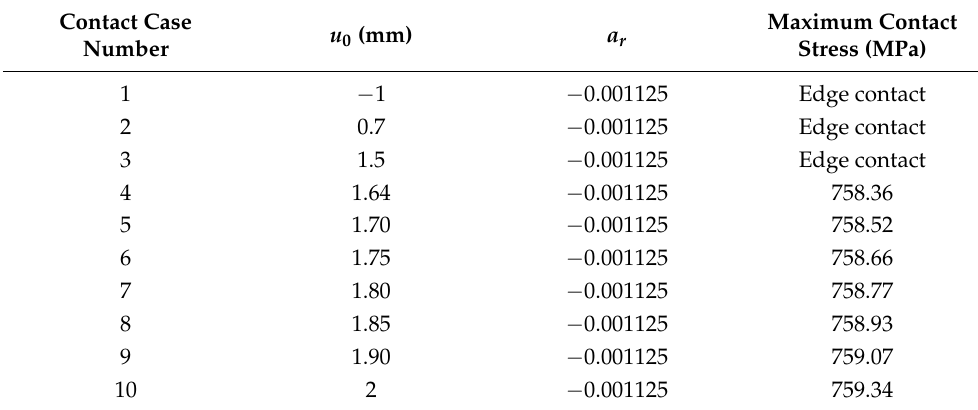
Table 4. Contact stress of different parabola offset distances u 0 .